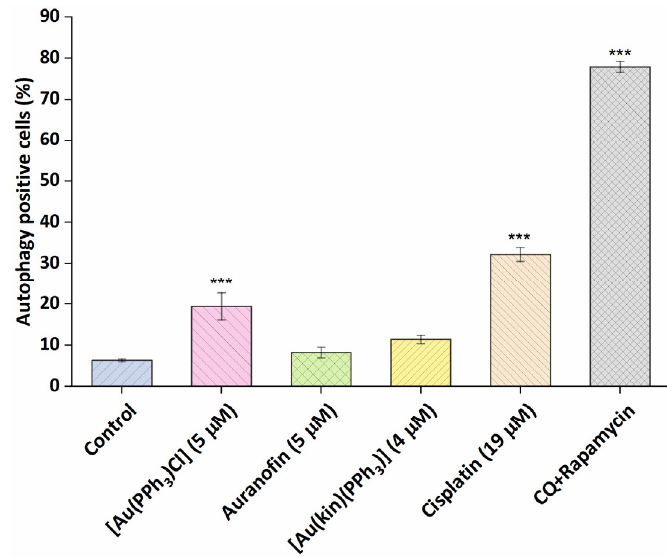
Figure 7. The effectiveness of ( 1 ), the starting complex [Au(PPh 3 )Cl], and the reference drugs